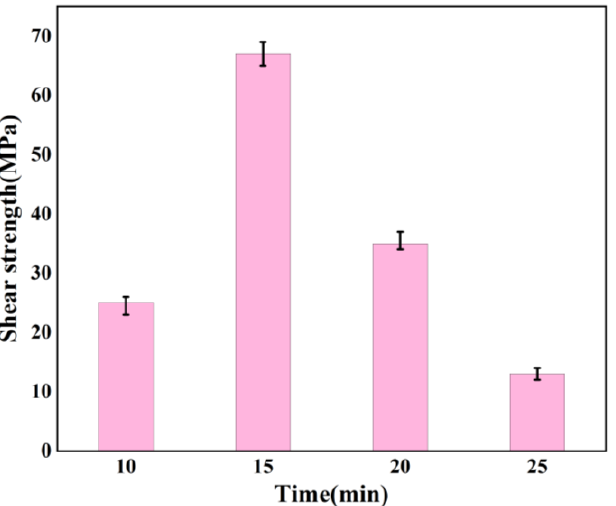
Figure 8. The shear strength of the joint brazed at 890 °C for different holding times.